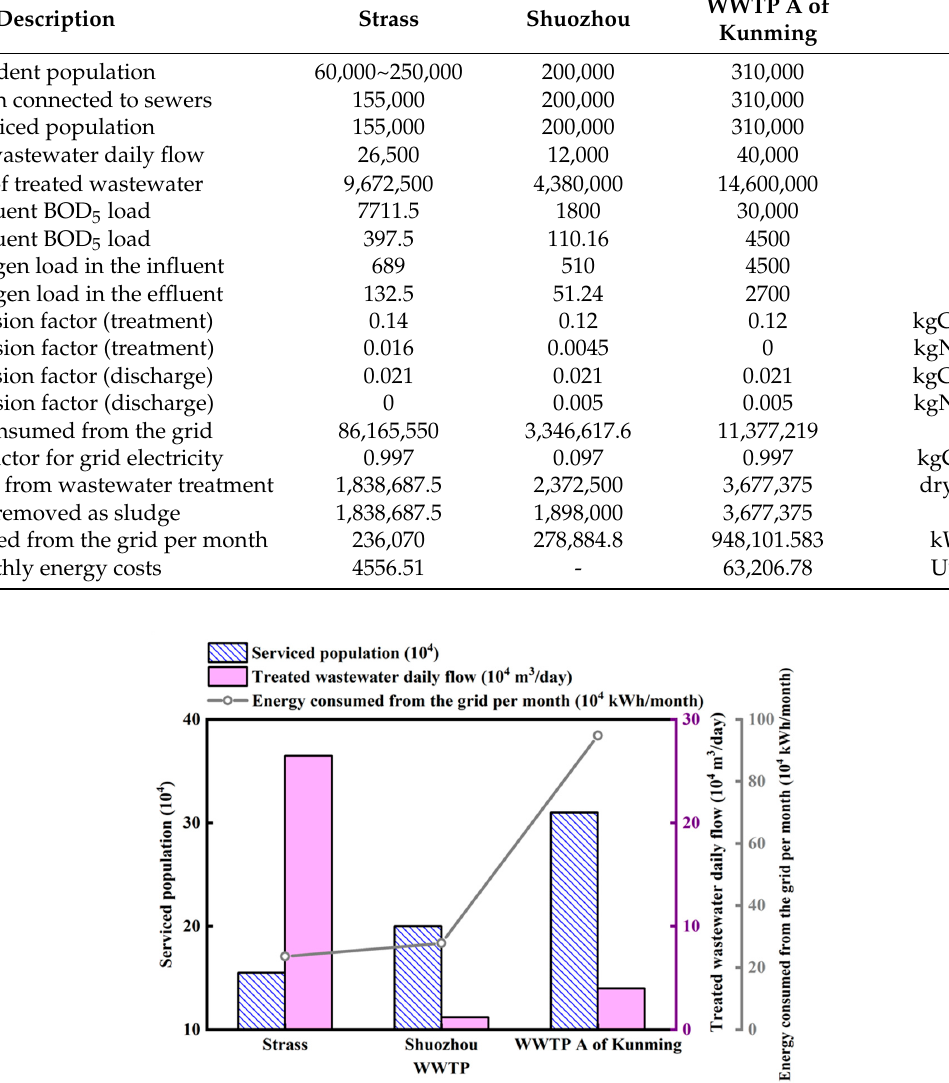
Figure 5. The relationship among service population, treatment capacity and energy consumption of different WWTPs in different regions.